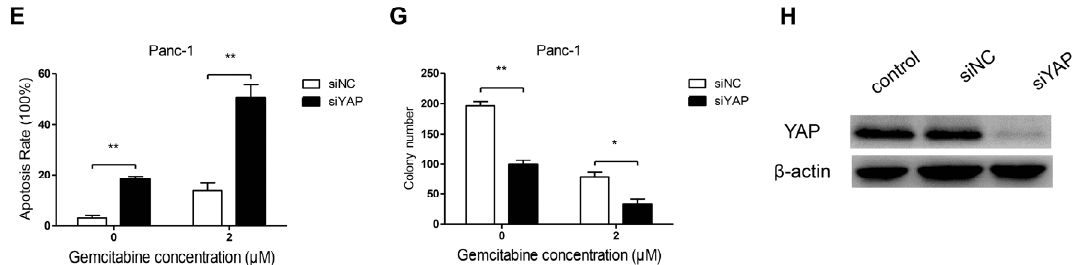
Figure 5. Knockdown of YAP increases gemcitabine sensitivity in pancreatic cancer cells. ( A , B ) Panc ‐ 1 and BxPC ‐ 3 cells were treated with increasing concentrations of gemcitabine (0, 1, 2, 5, 10, and 20 μ M) for 24 h, 48 h, or 72 h to analyze the inhibition ratio for cancer cell proliferation; ( C ) After being transfected with siControl or siYAP for 48 h, cells were plated in 96 ‐ well plates and treated with 2 μ M gemcitabine for 72 h. Cell viability was assessed by the MTT assay; ( D , E ) The effects of siControl or siYAP on Panc ‐ 1 cancer cells apoptosis after treatment with 2 μ M gemcitabine for 48 h was detected by flow cytometry; ( F , G ) The effects of siControl or siYAP combined with gemcitabine on the colony ‐ forming ability of Panc ‐ 1 cells. Images are representative of three independent experiments (Scale bar: 1 cm); ( H ) The efficiency of siRNAs targeting YAP in Panc ‐ 1cells was evaluated by Western blot analysis. Column: Mean, bar: SD, * p < 0.05, ** p < 0.01.